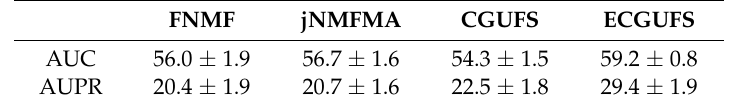
Table 2. Performance mean ± standard deviation of FNMF, jNMFMA, CGUFS, and ECGUFS.